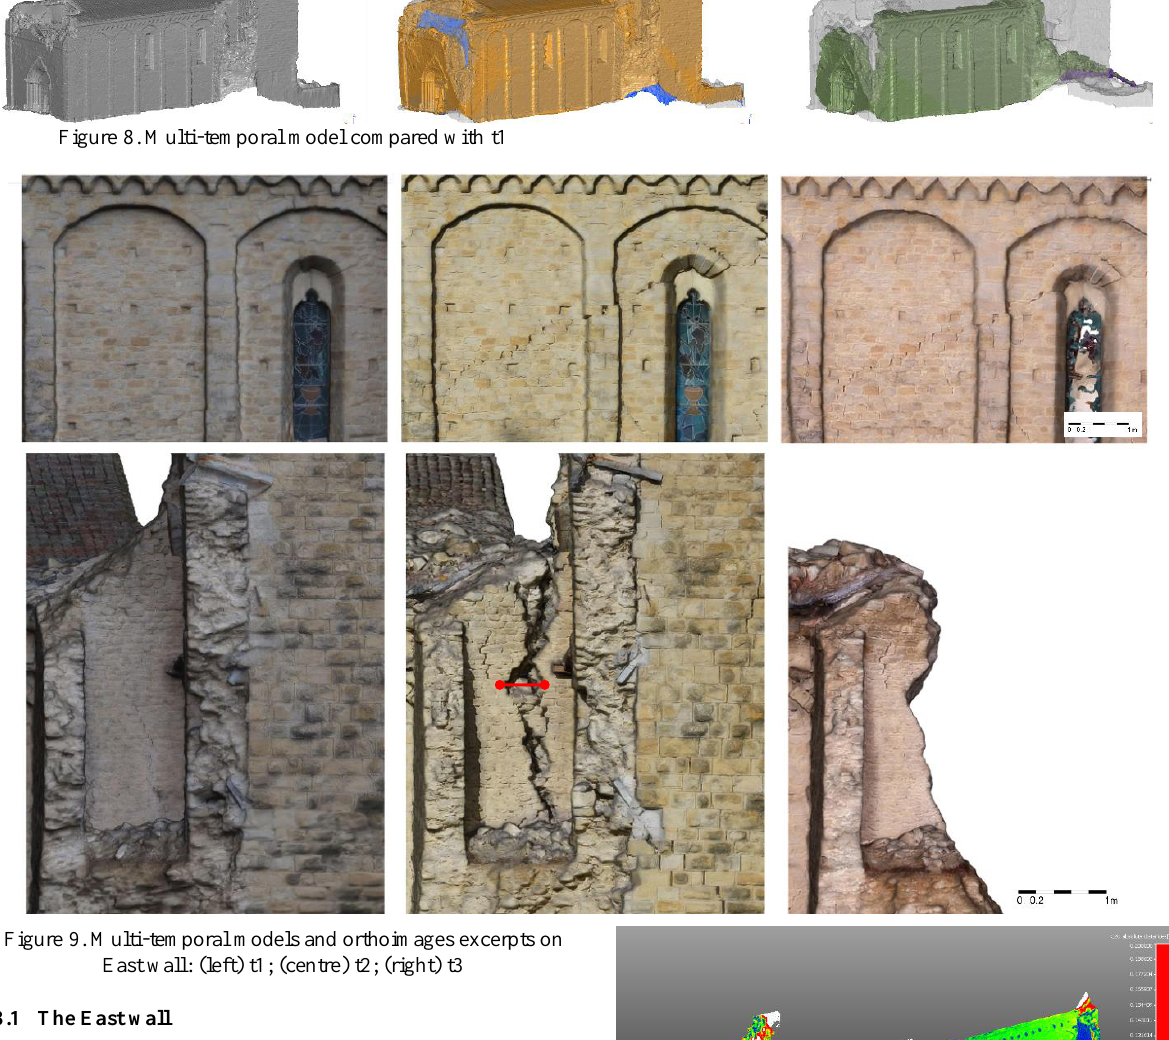
Figure 9. Multi-temporal models and orthoimages excerpts on East wall: (left) t1; (centre) t2; (right) t3